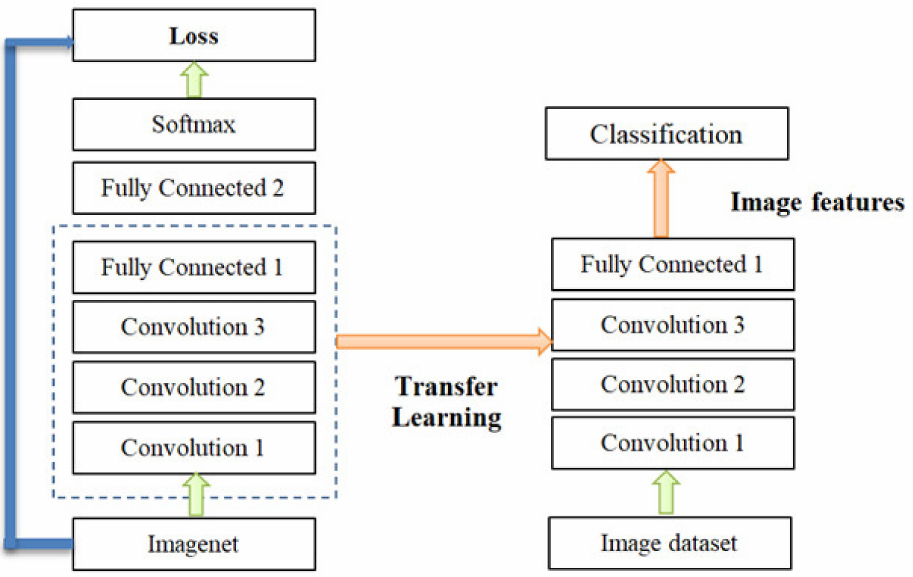
Figure 6. Convolutional neural network (CNN) transfer